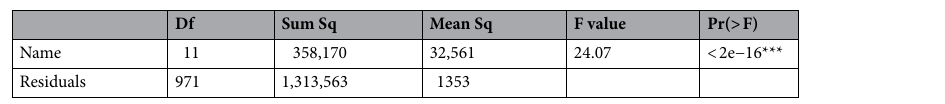
Table 2. The result of ANOVA test for the flowering temperature of Heloniadeae. Signif. codes: 0 ‘***’0.001 ‘**’0.01 ‘*’0.05 ‘.’0.1 ‘ ’1.